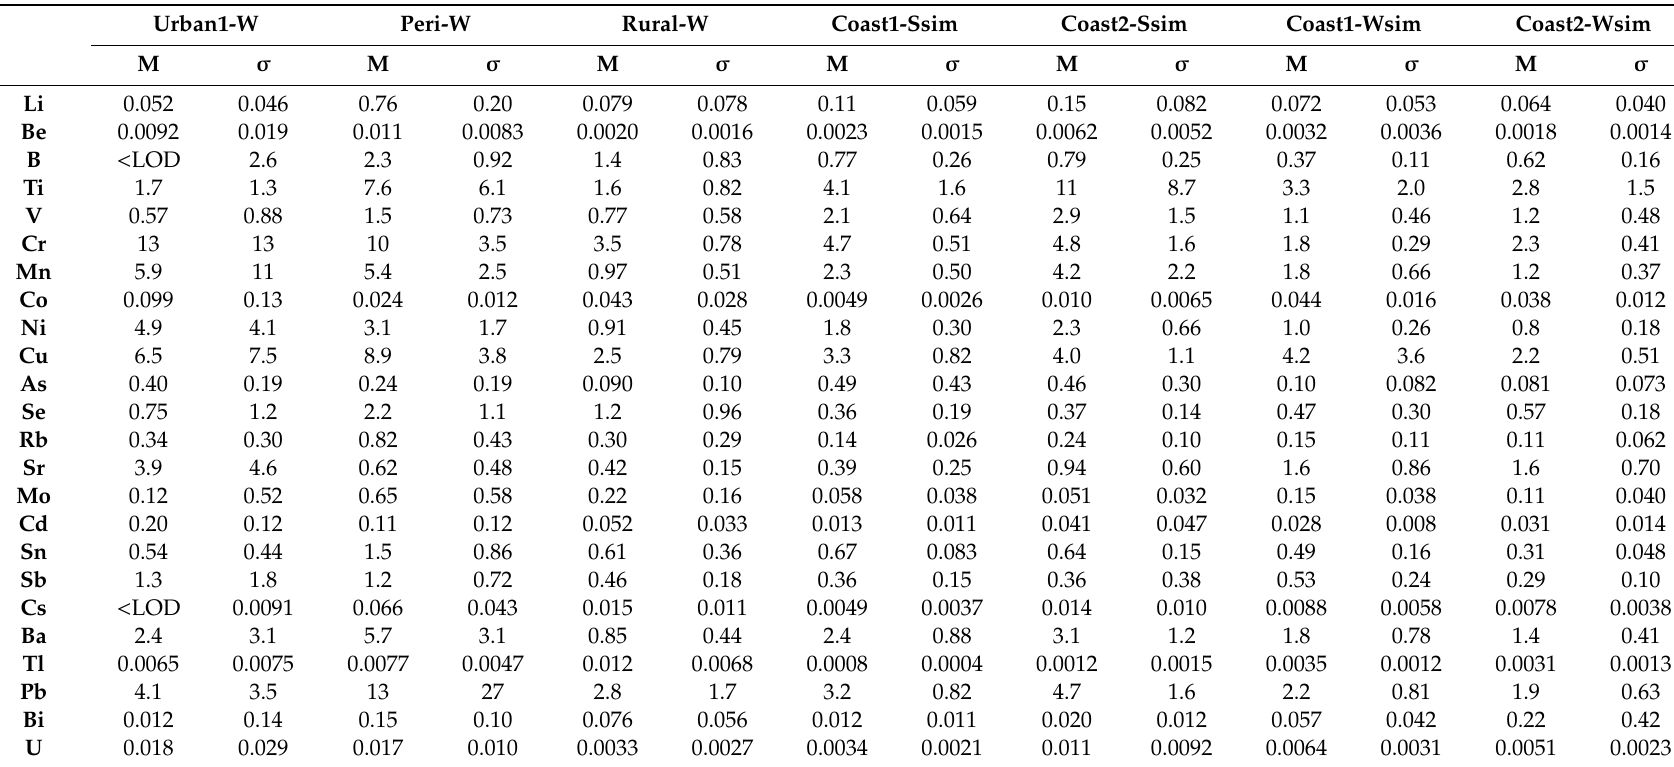
Table 7. Average mass concentrations (M) and standard deviations ( σ ) (in ng / m 3 ) of the residual micro- and trace-components measured outdoors. * < LOD indicates a value below the limit of